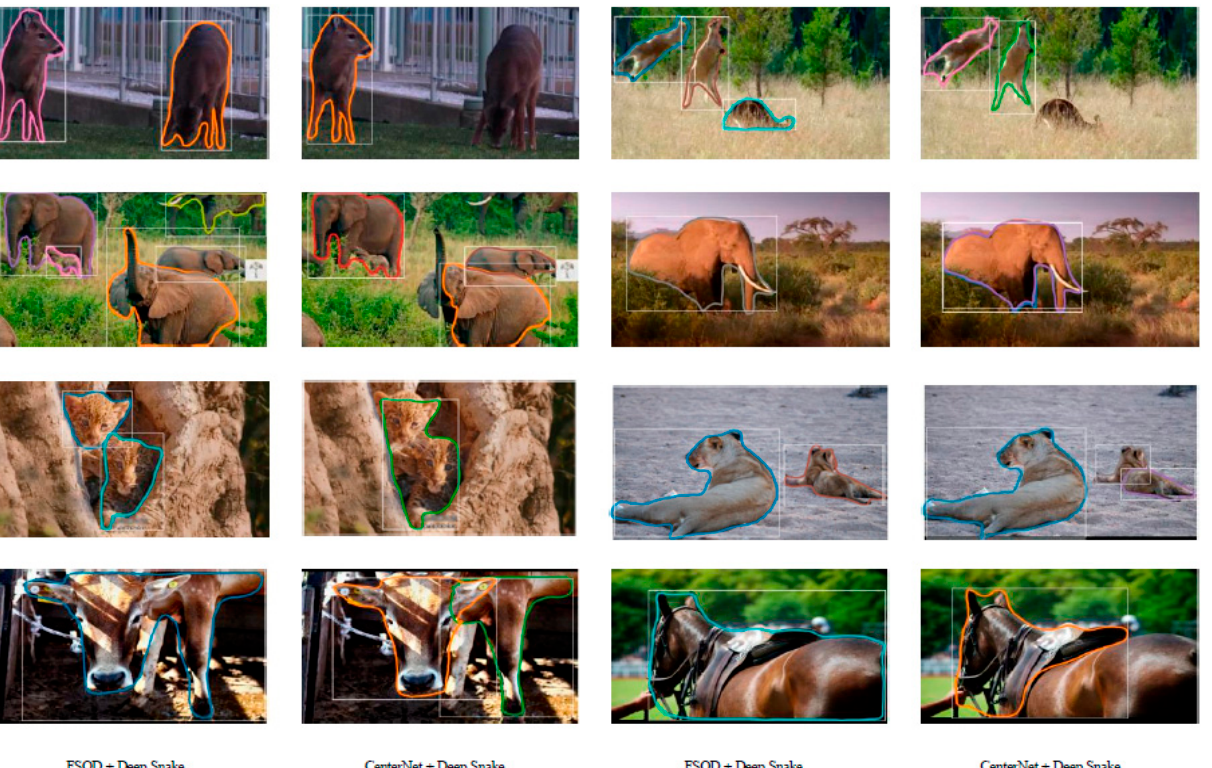
Figure 10. Contour approximation comparison between the proposed method and the CenterNet method. First row: multiple animals; second row: occluded or overlapped; third row: camouflaged; fourth row: incomplete body. For the above challenging images, the proposed model can detect animal contours correctly. However, CenterNet encountered some problems, such as missing the animals, regressing two animals into a contour, or dividing an animal into two parts. Table 3. Comparison of fps, AP, and AP50 results of animal segmentation.